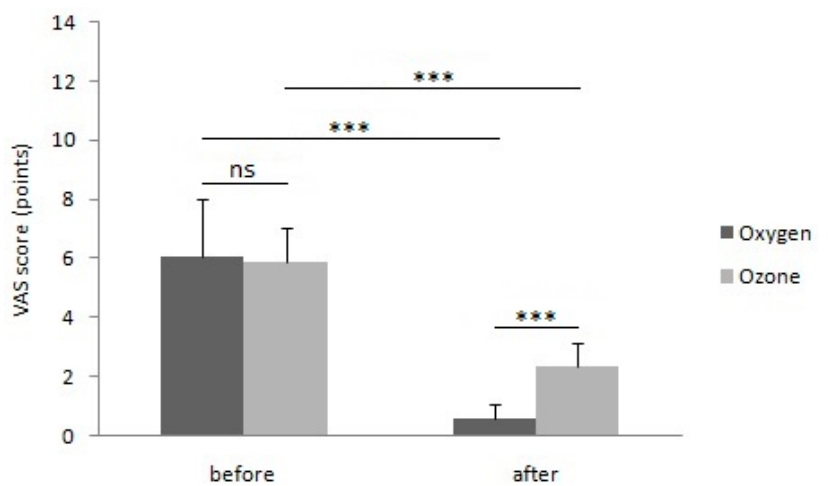
Figure 2. Comparison of pain intensity assessed using the VAS scale in patients treated by means of local hyperbaric oxygen therapy and ozone therapy, before and after the treatment cycle. (ns: not significant; *** p < 0.001).